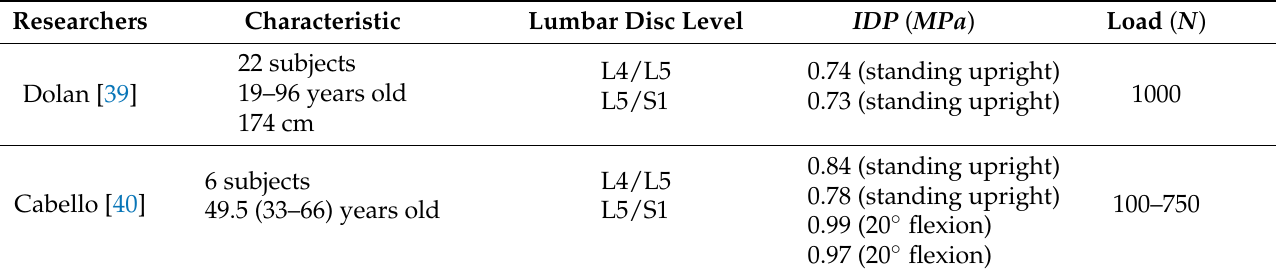
Table 5. Comparison of IDP at L4/L5 and L5/S1.